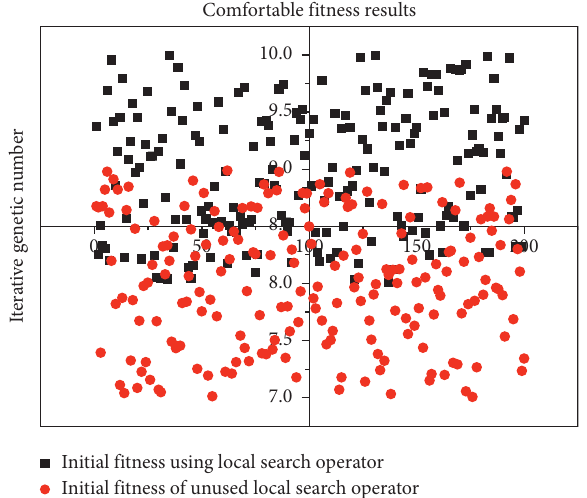
Figure 5: Comparison of initialized chromosome